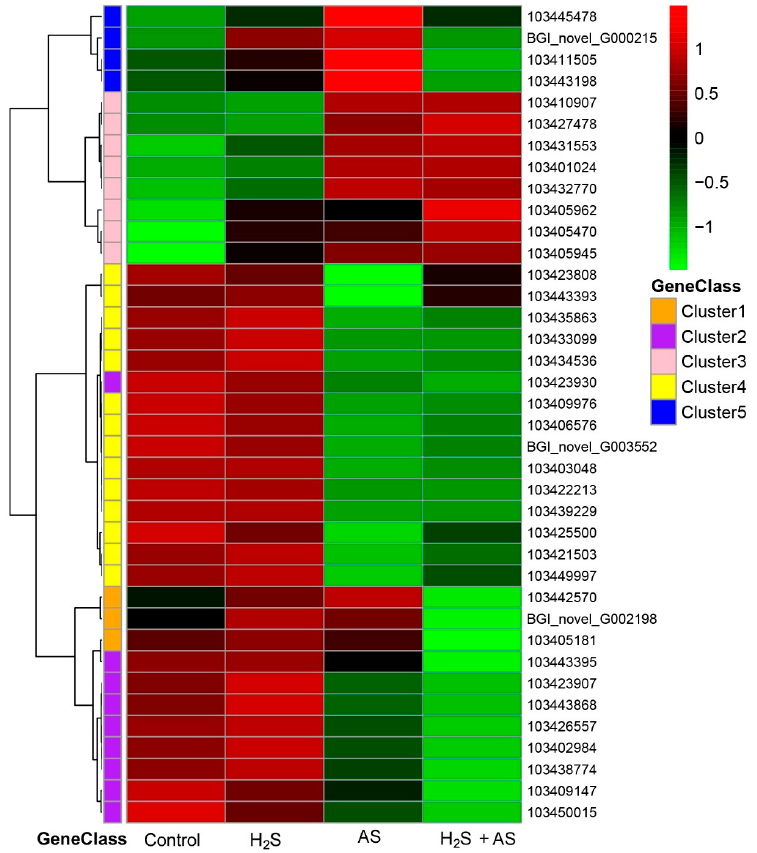
Figure 7. Role of cell wall metabolism–related genes in the mitigation of alkaline salt stress by H 2 S of M. hupehensis root.